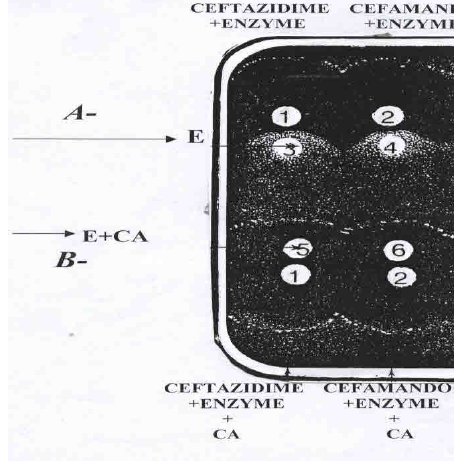
Figure(2):Antibiotic – enzyme interactions, by the highly sensitive double disks technique (25) demonstrated the inhibition of  - lactamases by clavulanic acid. A and B: 1 and 2 -disks of Figure (4) :Hydrolysis of Cephalosprins by Ceftazidime (Cfz) 30µg, and Cefamandol Cephalosporinase ( β – Lactamase ) , extracted (Cfm) 30µg , 3 and 4 disks at a distance of 2 cm from E.cloacae P99 ( According to Sirot , from Cfz and Cfm impregnated with (10µl) of D,1983 ) enzyme(  - lactamase)5 and 6 disks impregnated with 10µl enzyme + 10µl Clavulanic acid (CA).